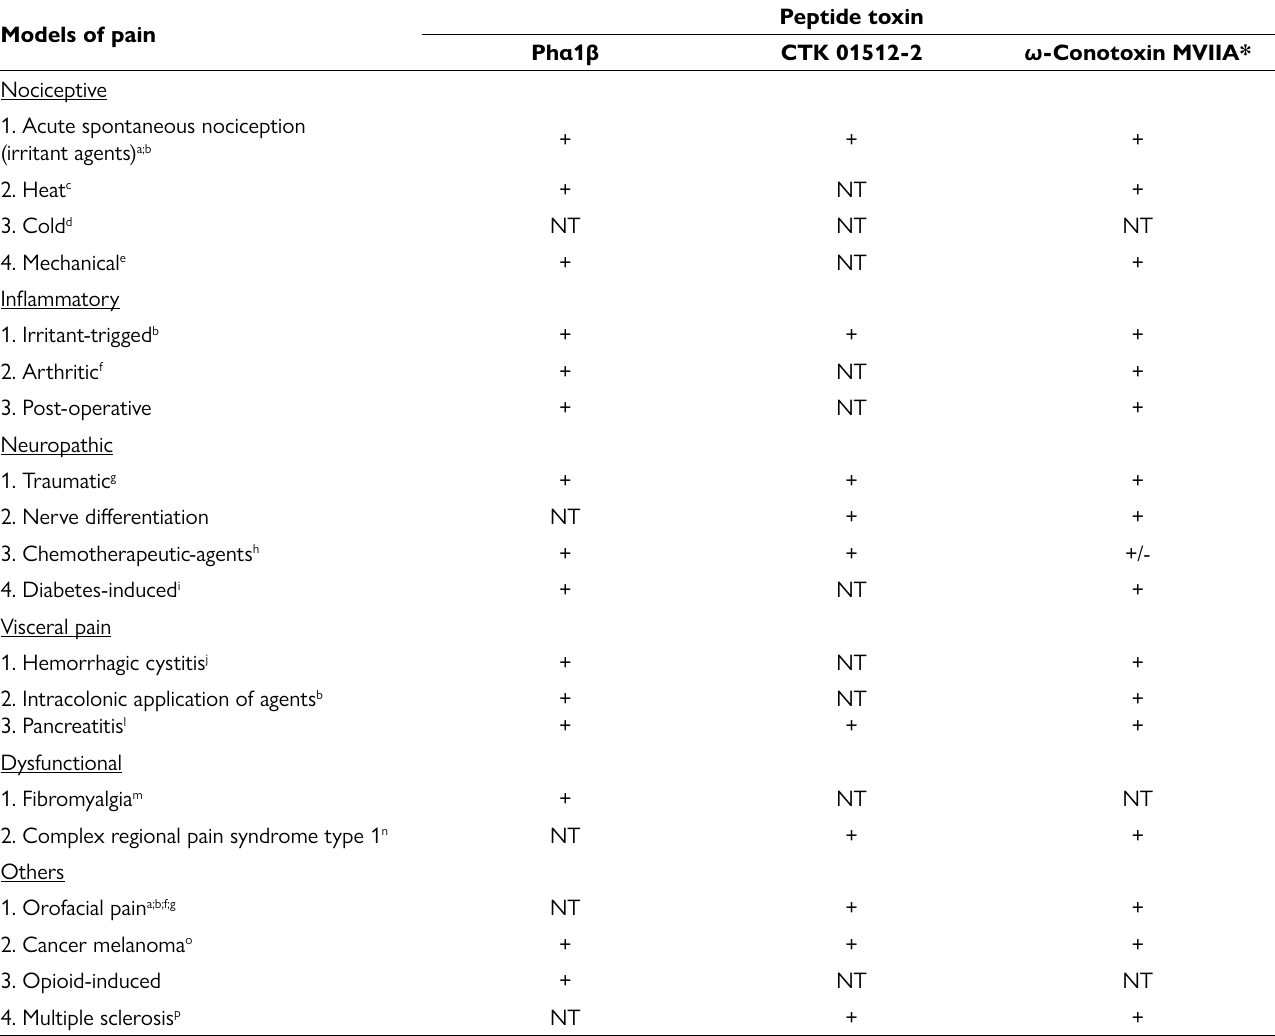
Table 1. Analgesic-like effects of Phα1β, CTK 01512-2 and ω -conotoxin MVIIA (Ziconotide, Prialt ® ) in different models of rodent